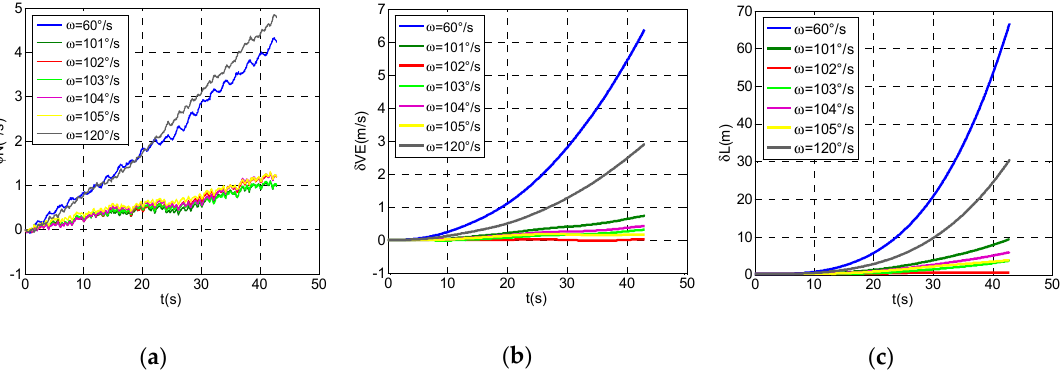
Figure 6. ( a ) The north attitude errors at different modulation angular rates. ( b ) The east velocity errors at different modulation angular rates. ( c ) The latitude errors at different modulation angular rates.